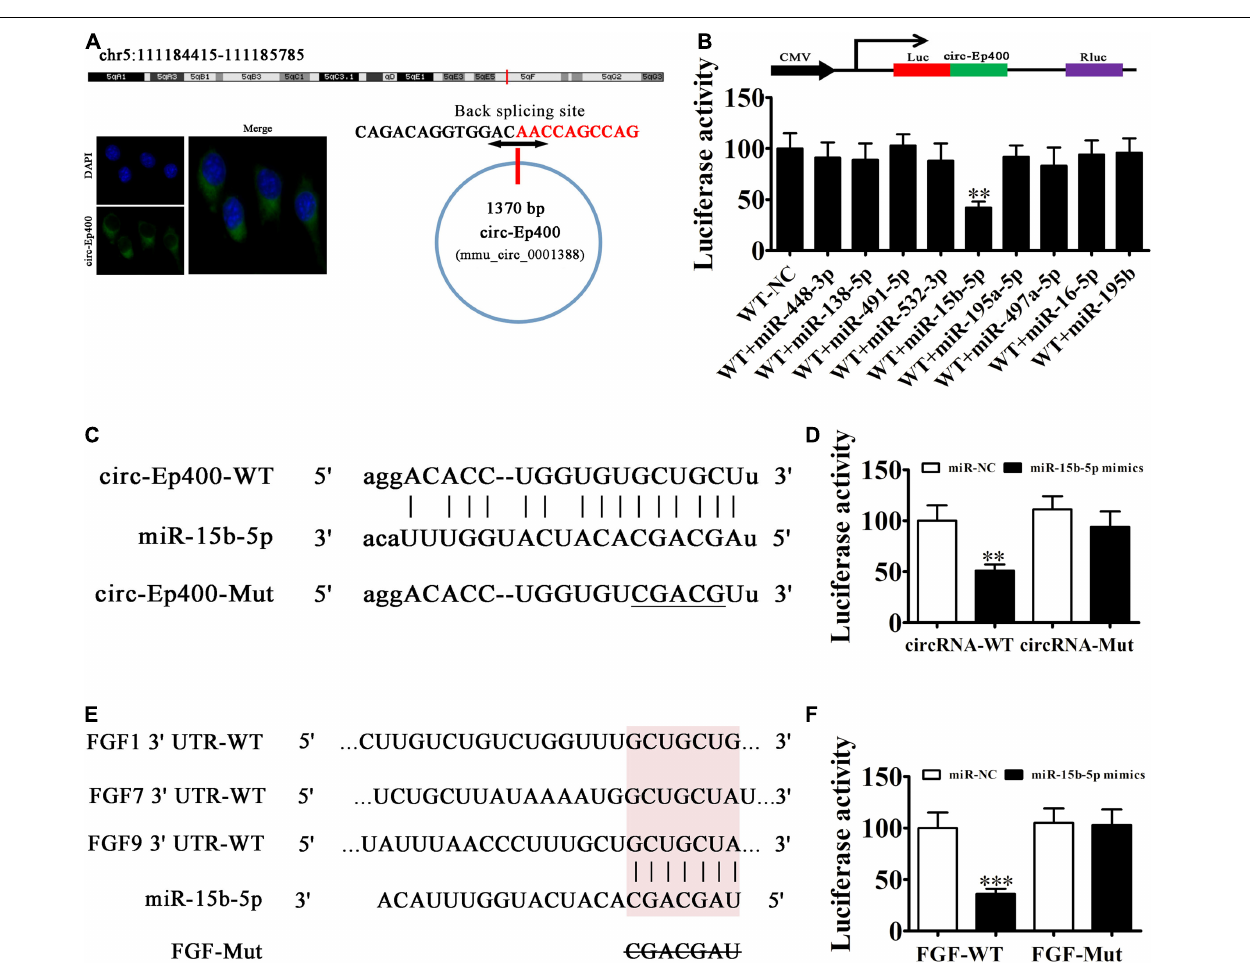
Frontiers in Cell and Developmental Biology |